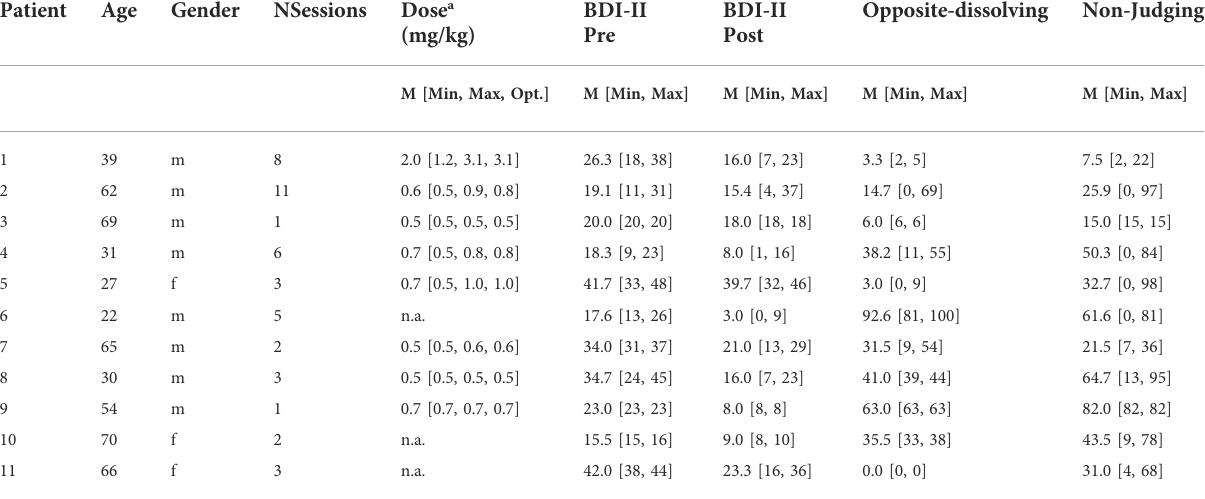
TABLE 1 Mean BDI-II and opposite-dissolving and non-judging values for all patients.